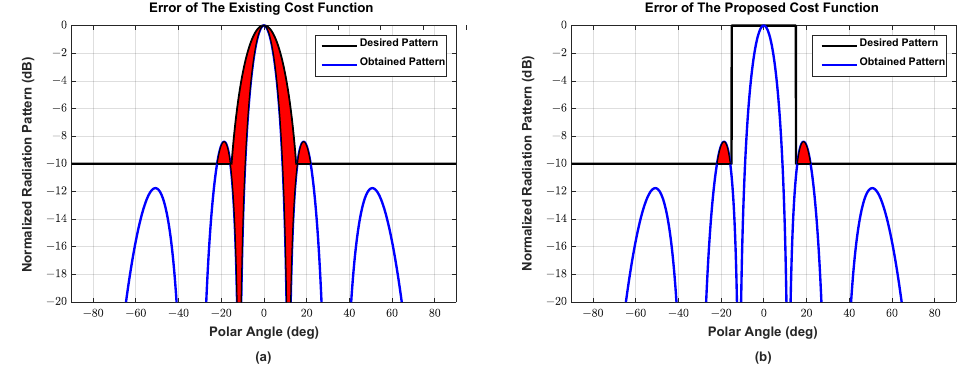
Figure 3. Two examples of ( a ) the existing cost function and ( b ) the proposed cost